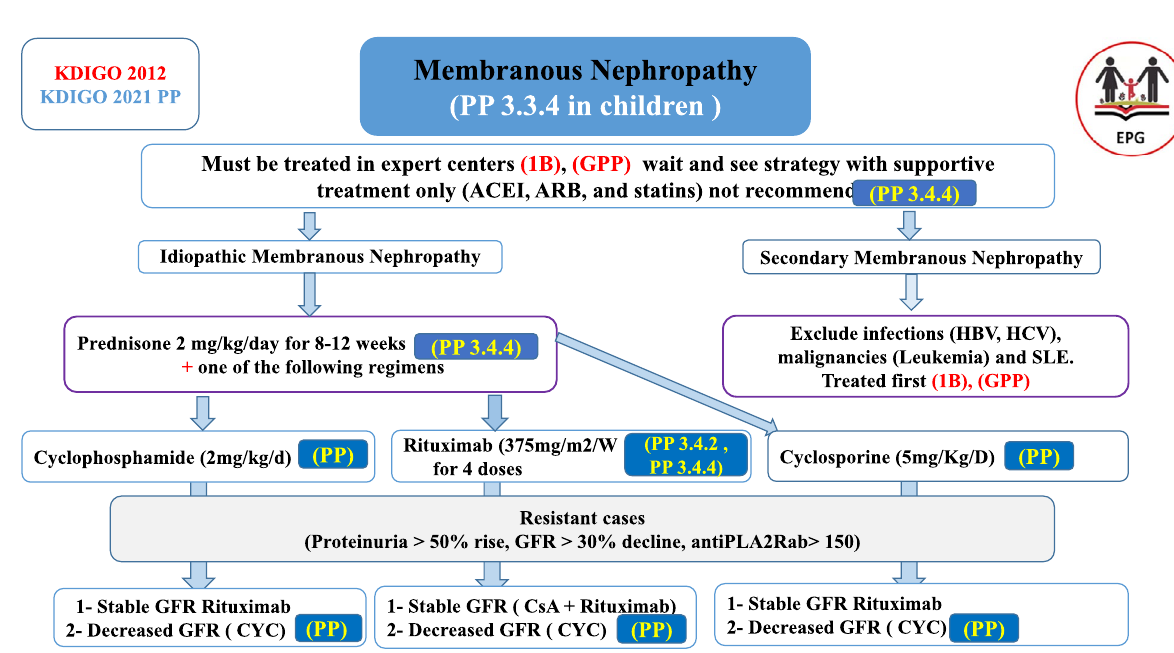
Fig. 7 EPG management of MN. R 3.2.2